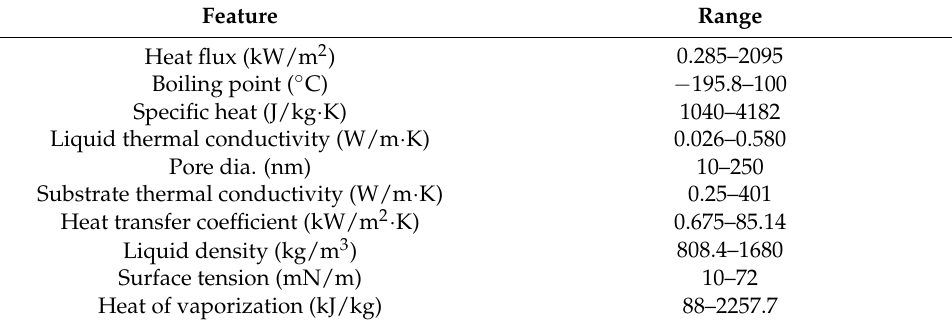
Table 1. Range of the considered parameters